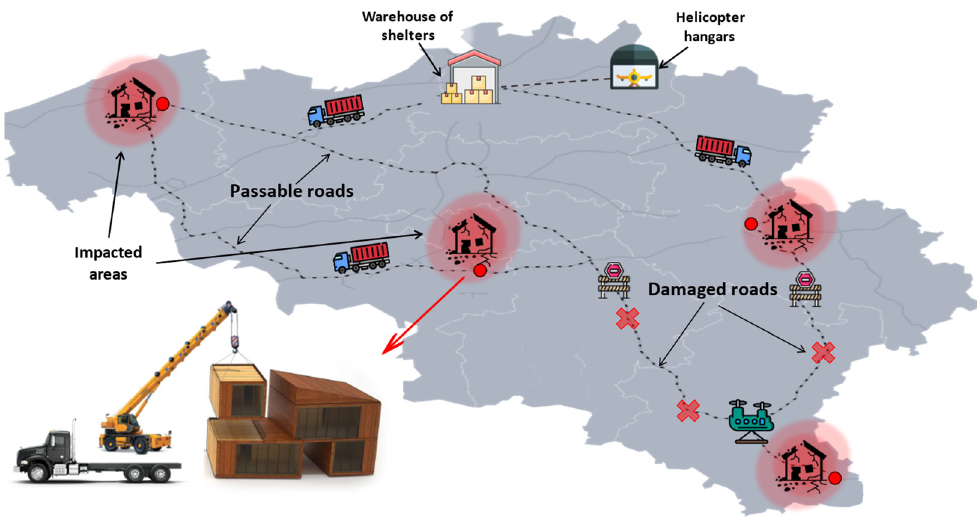
Figure 4. A schematic sample of the problem.